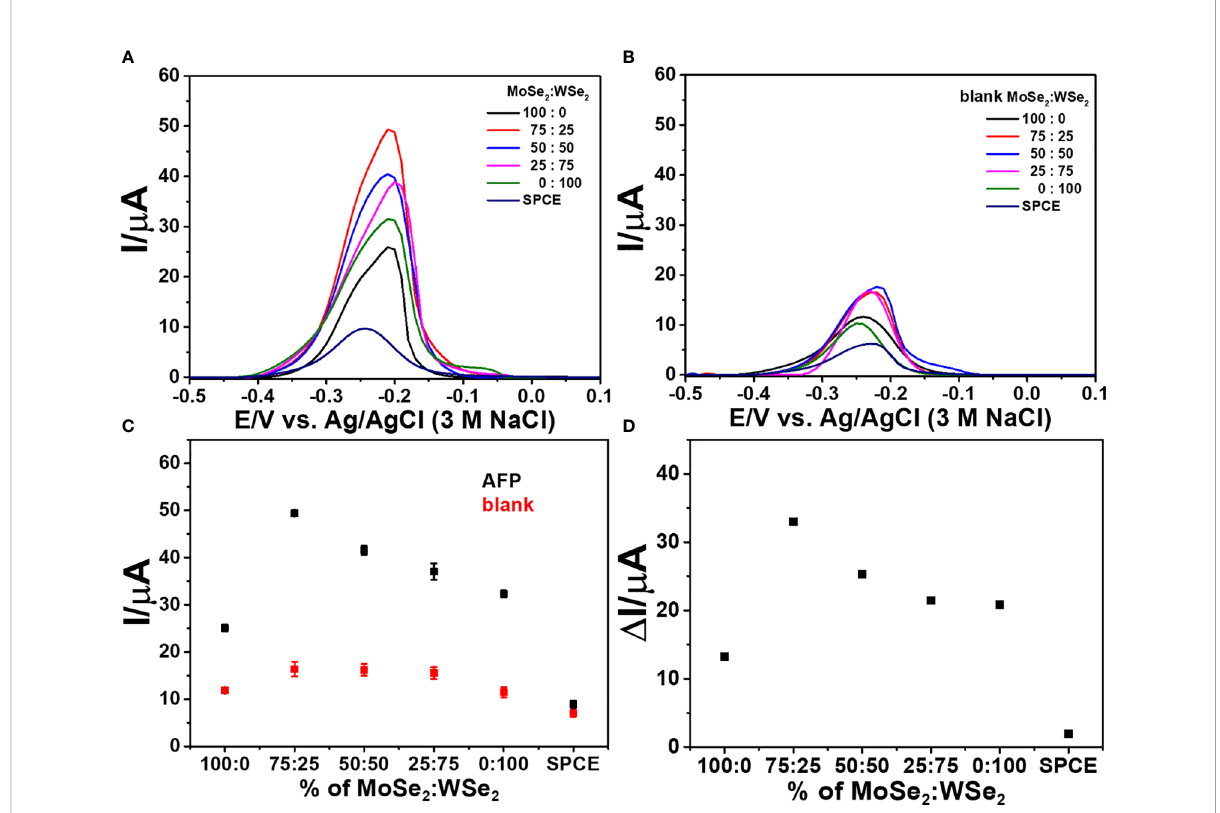
FIGURE 4 DPV responses of the sandwich-like immunosensors with different ratios of 2D MoSe 2 /2D WSe 2 in contact with 0.010 M PBS (pH 7.4); (A) with and (B) without AFP after incubation with MB. (C) Corresponding current responses of panels ( A , B , D) analytical responses or current differences of panel (C)